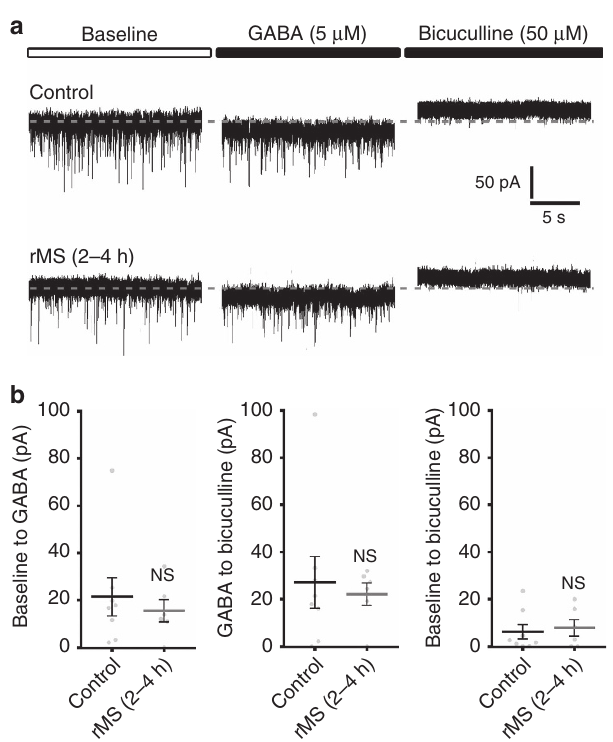
Figure 2 | Tonic GABA A R conductance is not affected after rMS. ( a ) Sample traces depicting GABA- (5 m M) and bicuculline-methiodide (50 m M)- induced shift in tonic GABA A R-mediated currents recorded from CA1 pyramidal neurons in non-stimulated control and stimulated slice cultures (2–4h after rMS). Baseline currents were not significantly different between the two groups (control: 191.2 ± 12.1pA; rMS: 187.5 ± 13.6pA; P ¼ 0.57; control, n ¼ 8 neurons; rMS, n ¼ 6 neurons; one cell per culture; Mann– Whitney test). ( b ) The amplitude of GABA- or bicuculline-methiodide- induced shifts in tonic GABA A R currents of CA1 pyramidal neurons is not significantly different between stimulated and non-stimulated slice cultures (control, n ¼ 8 neurons; rMS, n ¼ 6 neurons; one cell per culture; Mann– Whitney test). Individual data points are indicated by grey dots. Values represent mean ± s.e.m. (ns, not significant